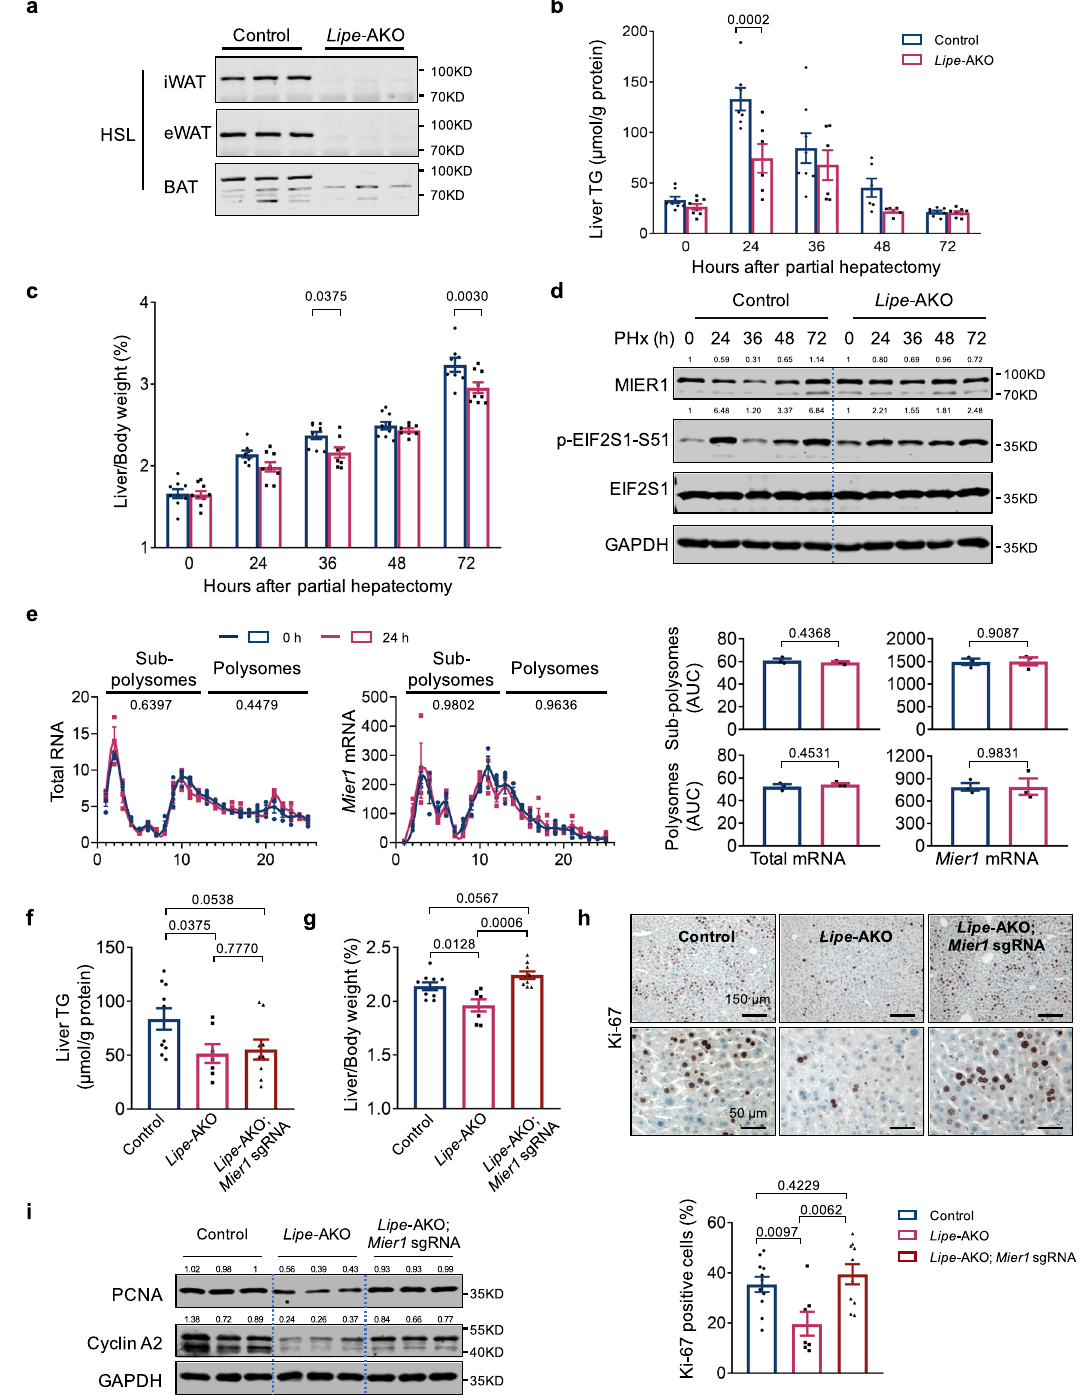
Fig.5|Decreasedlipidaccumulationduetoadiposelipolysisdysfunctionleads to compromised MIER1 regulation and impaired liver regeneration. a Immunoblot (HSL) in Control and Lipe- AKO adipose tissues. The liver triglycer- ides (TG) content ( b ) ( n =8, 7, 8, 6, 8 in Control group, and n =8, 6, 6, 6, 8 in Lipe- AKOgroup,atdifferenttimepointsafterPHx),liver/bodyweightratio(%)( c )( n =9, 8,10,10,8inControlgroup,and n =9,9,8,8,9in Lipe- AKOgroup,atdifferenttime points after PHx), immunoblots of liver MIER1 and EIF2S1 phosphorylation ( d ) in Control or Lipe -AKO animals before or after surgery. e Polysome pro fi les and qRT- PCR analysis of distributions of indicated transcripts in liver tissues collected before or 24h after hepatectomy from Lipe -AKO animals. n =3. The liver TG con- tent ( f ) (Control, n =10; Lipe -AKO, n =7; Lipe -AKO; Mier1 sgRNA, n =9), liver/body